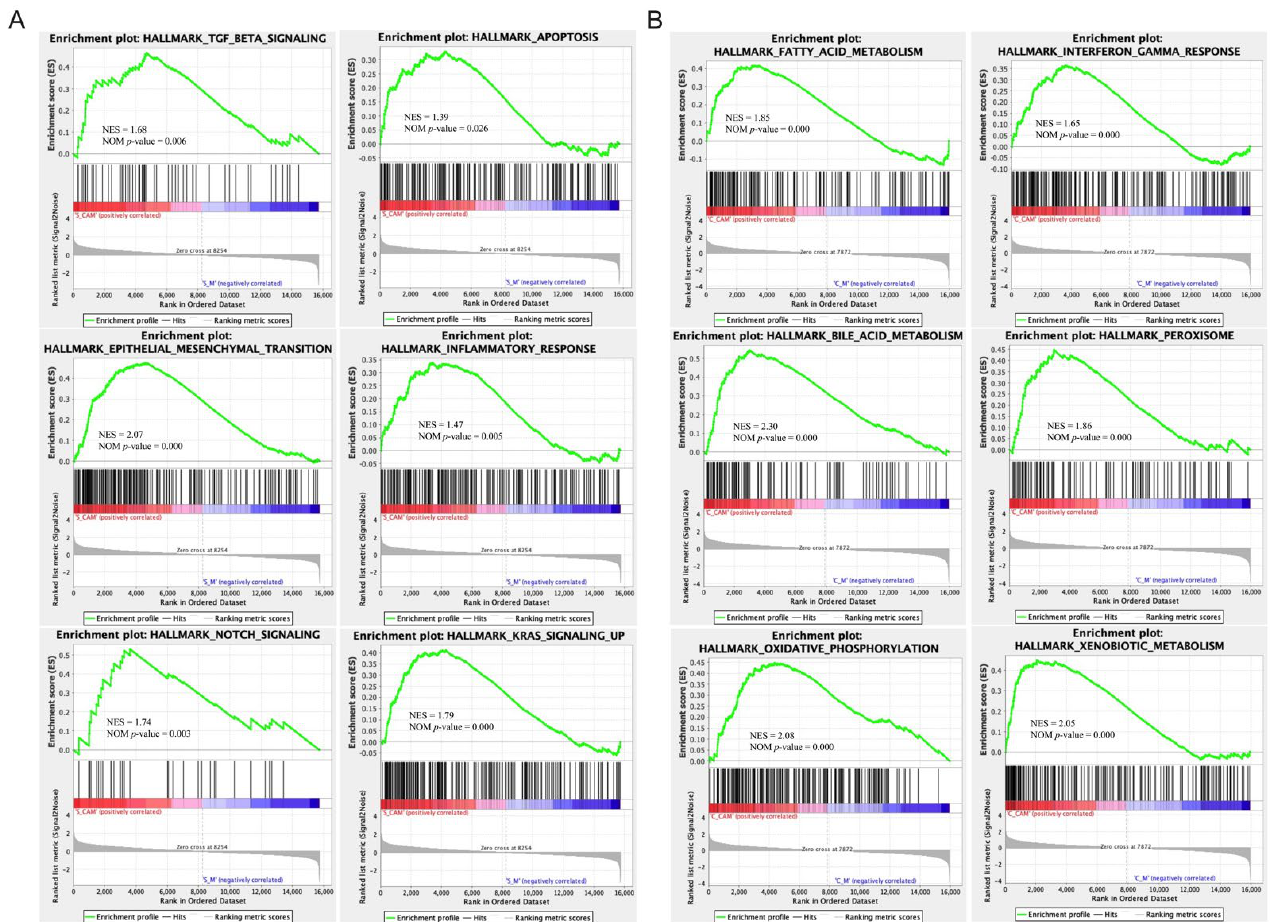
Figure 6. Enrichment plots from the gene set enrichment analysis (GSEA). ( A ) The significantly enriched hallmark terms associated with CA-mediated modulation on the spleen in PD mice. ( B ) The significantly enriched hallmark terms associated with CA-mediated modulation on the colon in PD mice. Cut-off value of |Normalized Enrichment Score (NES)| > 1.0 and nominal p -value < 0.05, n =